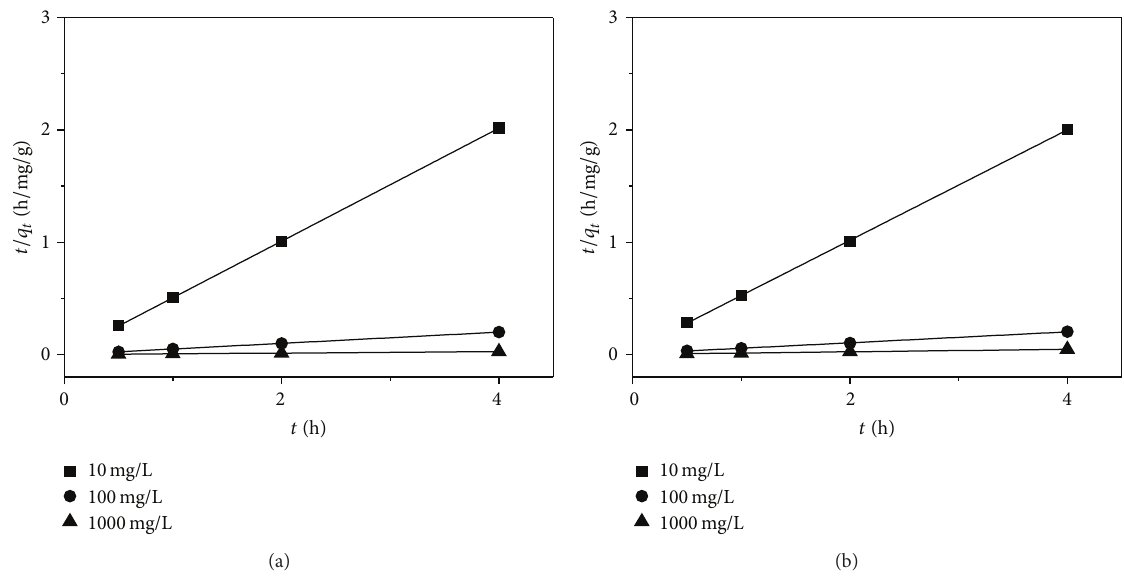
Figure 7: Pseudo-second-order kinetic model for adsorption of (a) Pb 2+ and (b) Cd 2+ on 30/70 HAp/chitosan hybrid fibers at initial metal ion concentration of 10mg/L (square), 100 mg/L (circle), and 1000mg/L (triangle).